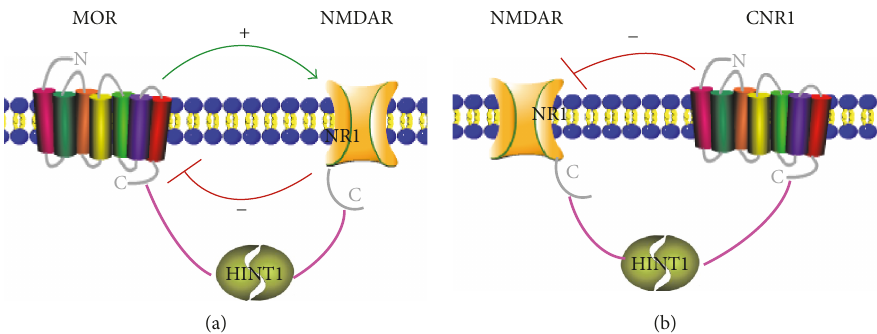
Figure 3: The pattern of HINT1 interacting with GPCRs. (a) HINT1 interacts with the C-terminus of μ -opioid receptor (MOR). HINT1 also interacts with the NR1 subunit of NMDAR. To prevent opioids from producing an excessive reduction of neuronal excitability, NMDARs are recruited to the MOR environment, where they become activated to restrain opioid signaling. In this context, HINT1 stabilizes the functional interaction between MOR and NMDAR. (b) HINT1 may also associate with cannabinoid receptor type I (CNR1). CNR1 can negatively regulate NMDAR function when the receptor is coupled to